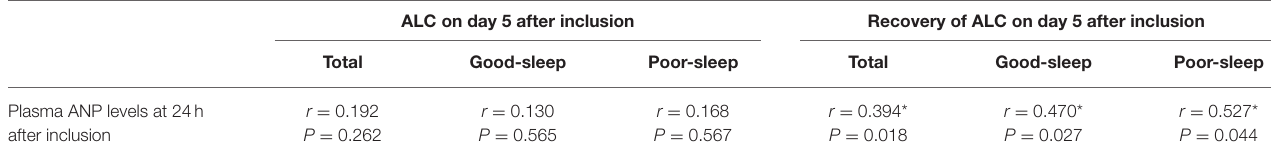
TABLE 4 | Correlation coefficient analysis of plasma ANP levels at 24h after inclusion with ALC on day 5 after inclusion and recovery of ALC on day 5 after inclusion.